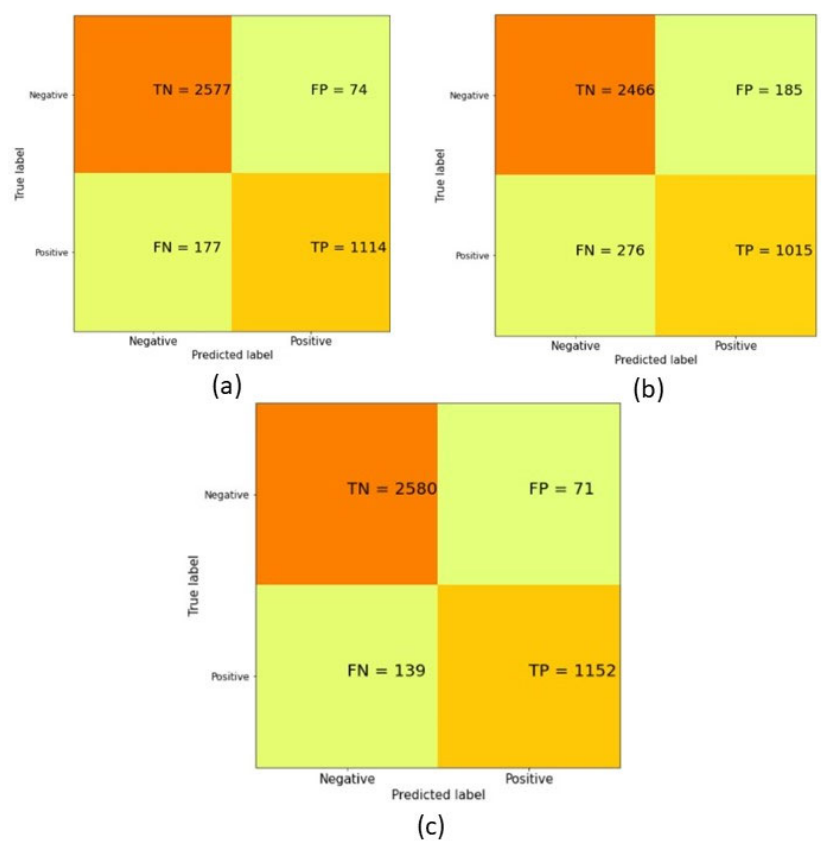
Figure 2. ( a ) Confusion matrix of ANN; ( b ) Confusion matrix of SVM; ( c ) Confusion matrix of Fusion (SVM ‐ ANN).